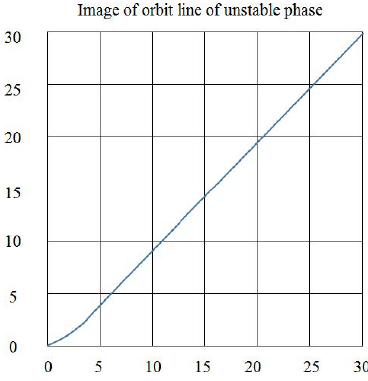
Fig. 4 Alpha beta & lt; phase orbit image at k